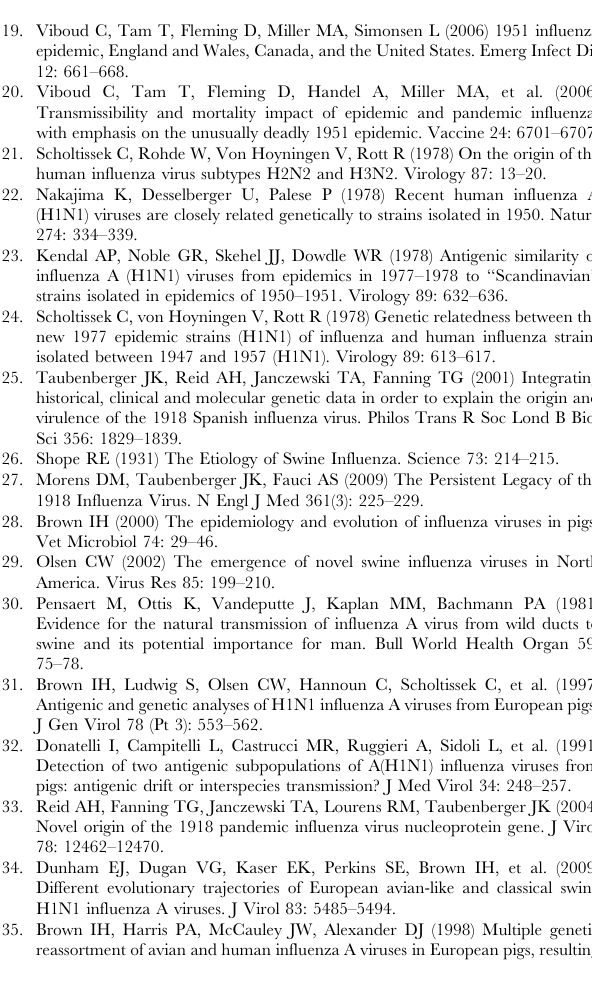
Figure S2 Phylogenetic tree of 32 HA sequences of egg-adapted human A(H1N1) influenza viruses isolated between 1933 , 1979. Figure S3 Phylogenetic tree of 42 HA sequences of swine A(H1N1) influenza viruses isolated between 1990 ,